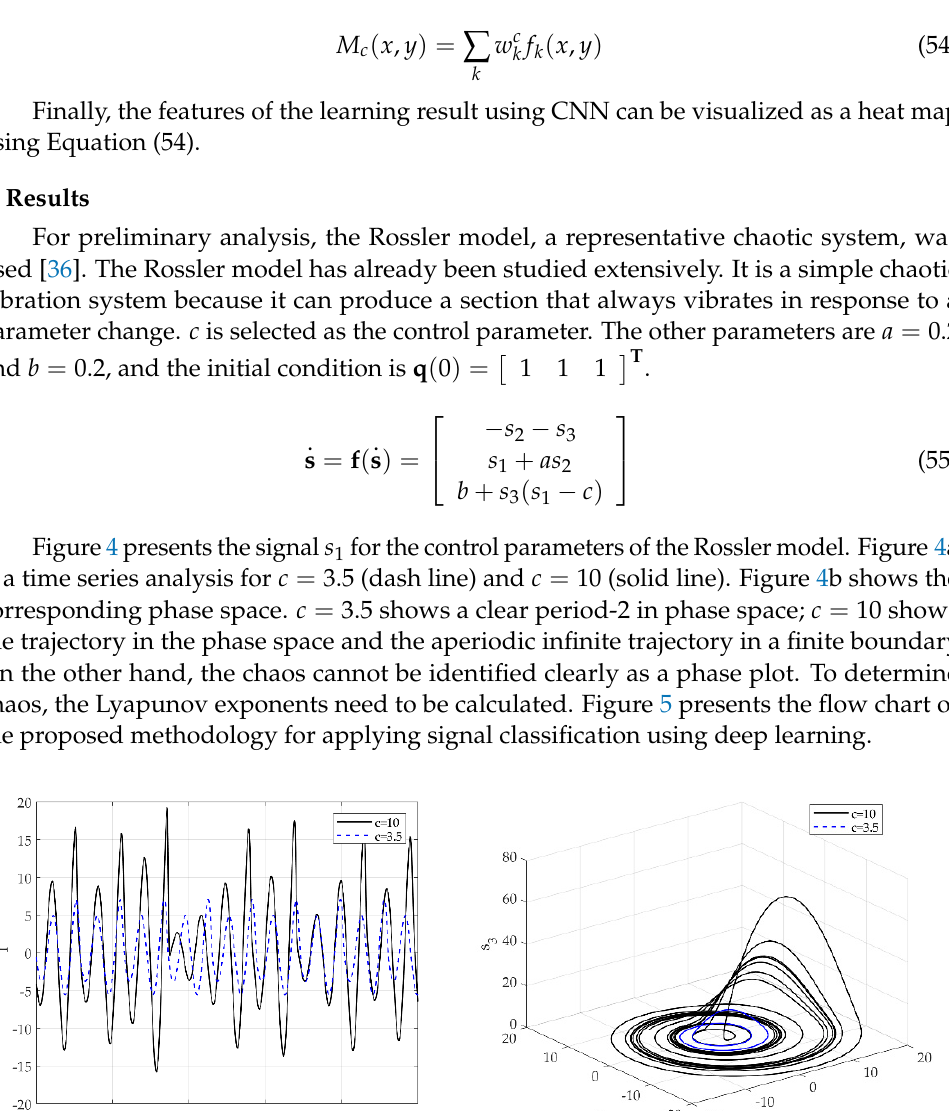
Figure 5. Flow diagram of the proposed methodology. As shown in the flow diagram, the proposed method classifies the characteristics of the nonlinear vibration signals not included in learning after learning a dataset of nonlin- ear vibration signals composed of images using the CNN architecture. In other words, the focus of this study was to learn the vibrating signal visualized based on RP by machine learning and to distinguish between the causes of vibration, such as friction or impact and chaotic characteristics. Details of the proposed method are as follows. First, the nonlinear time series data of the parametric deterministic dynamic system was obtained by numer- ical analysis using the Runge–Kutta method. The Lyapunov exponent was calculated for the time series data and chaos was determined. The image visualization method of the vibration signal used the FNN algorithm to determine the embedding dimension and re- construct the phase space. The reconstructed signal was expressed as an unthresholded RP to visualize the dynamic characteristics. Finally, the dataset composed of the visual- ized signals was trained by the CNN model and verified using the Lyapunov exponent.